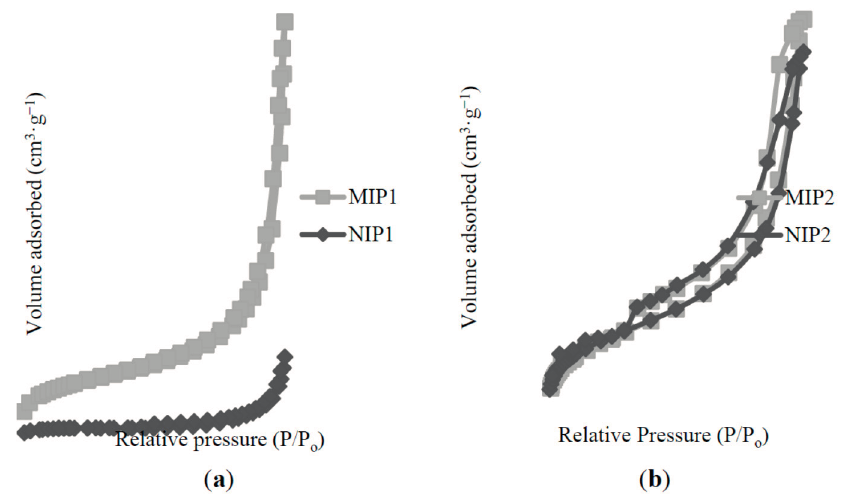
Figure 8. Nitrogen adsorption/desorption profiles of ( a ) MIP1/NIP1; ( b )